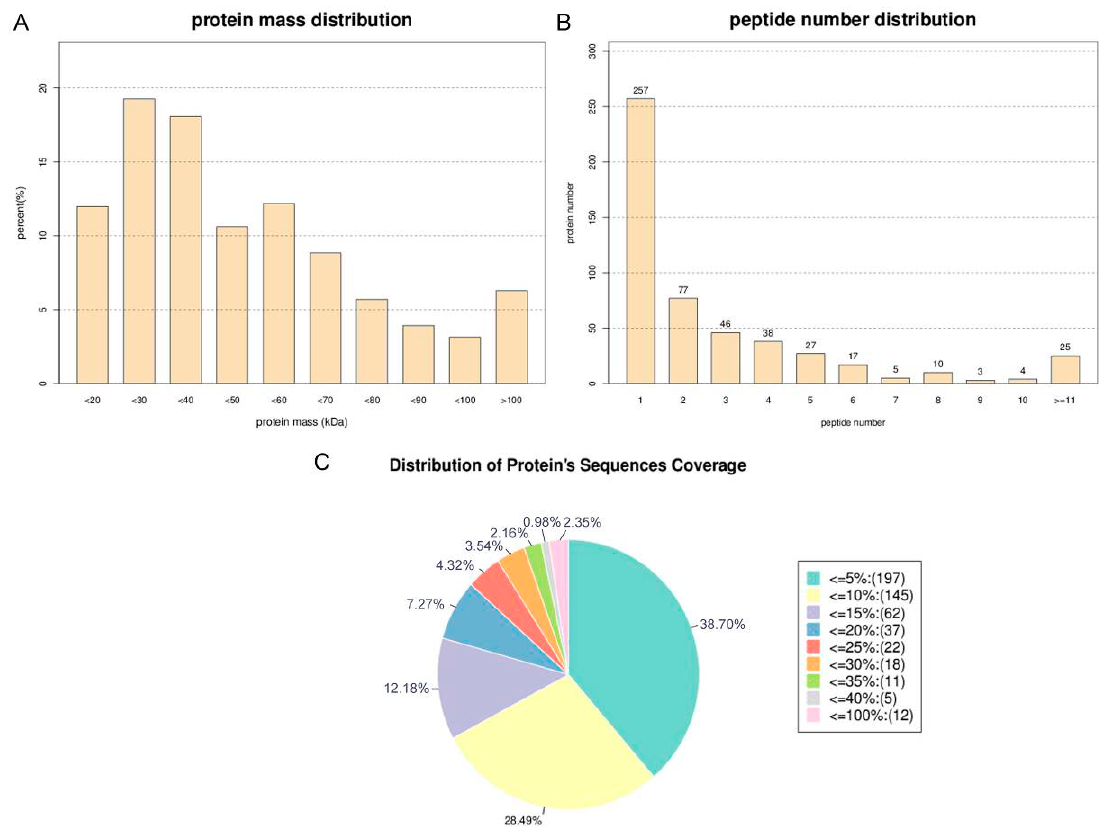
Figure 1. Identification and analysis of the Euphorbia kansui latex proteomics. ( A ) Identified proteins were grouped based on their protein mass. ( B ) The number of peptides that match to proteins as shown by Protein Piloy 5.0. ( C ) According to the protein sequence coverage, the identified proteins were classified into pie charts.